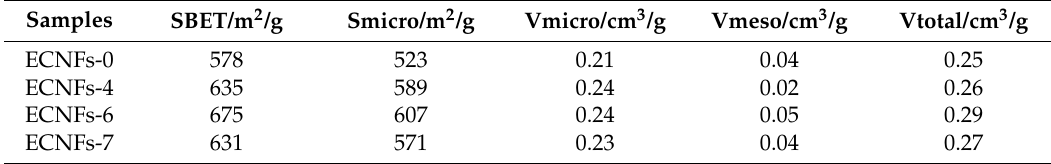
Table 1. Pore structure parameters of ECNFs.